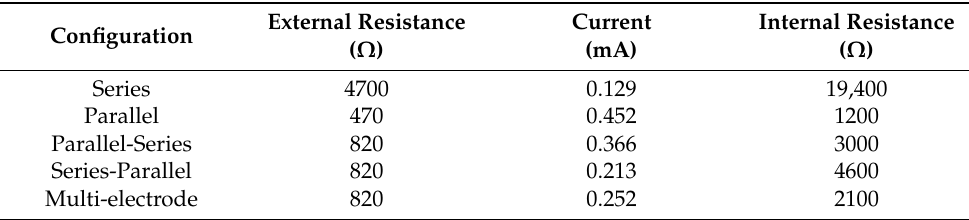
Table 4. Power overshoots conditions.